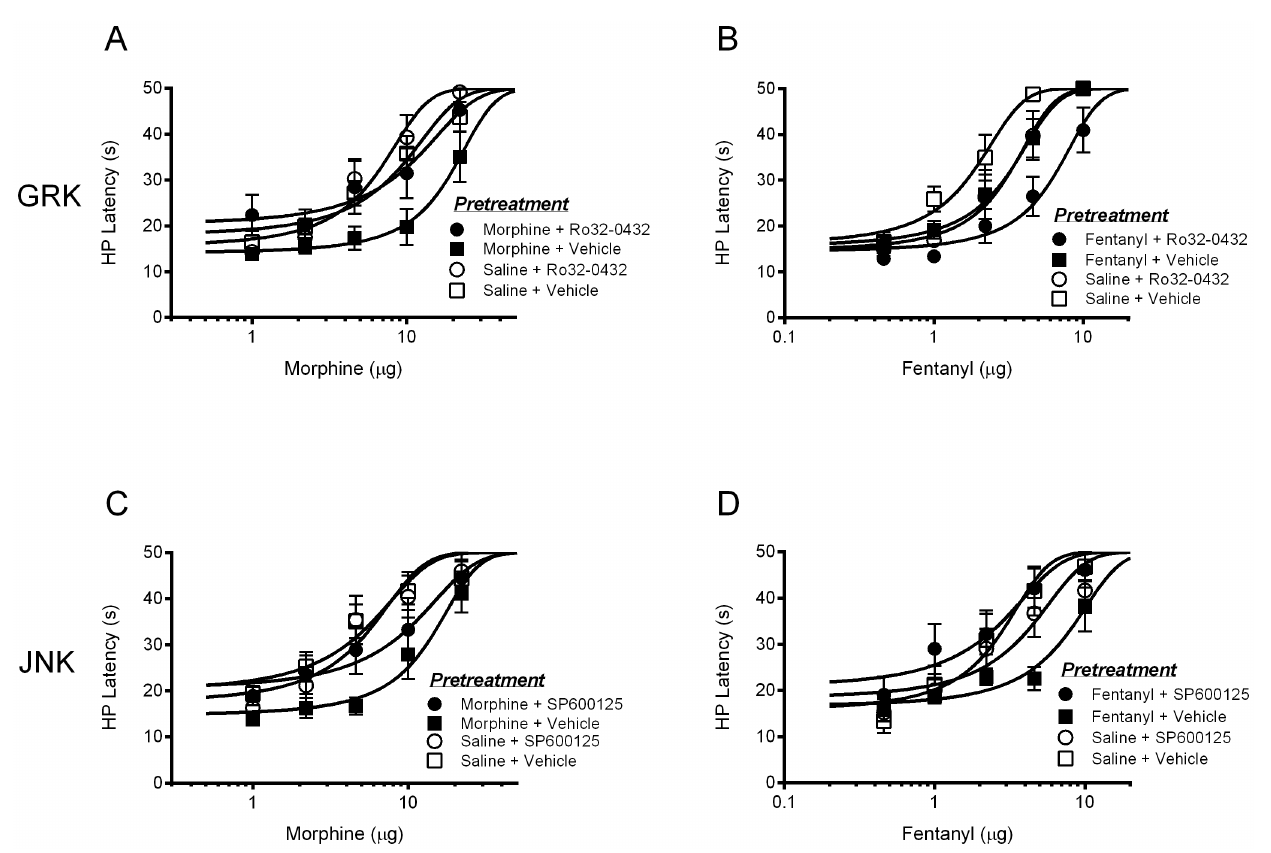
Fig. 7. Contribution of GRK/PKC and JNK to the development of morphine and fentanyl tolerance. A) Repeated microinjections of morphine into the ventrolateral PAG caused tolerance as evident by a rightward shift in the morphine dose response curve (F(3,157) 5 3.689, p 5 .0043). Administration of the